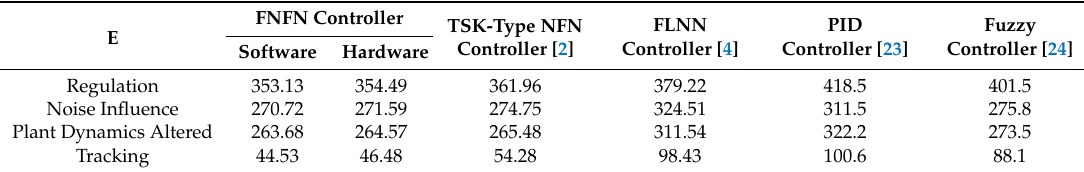
Table 2. Results of the comparison of various